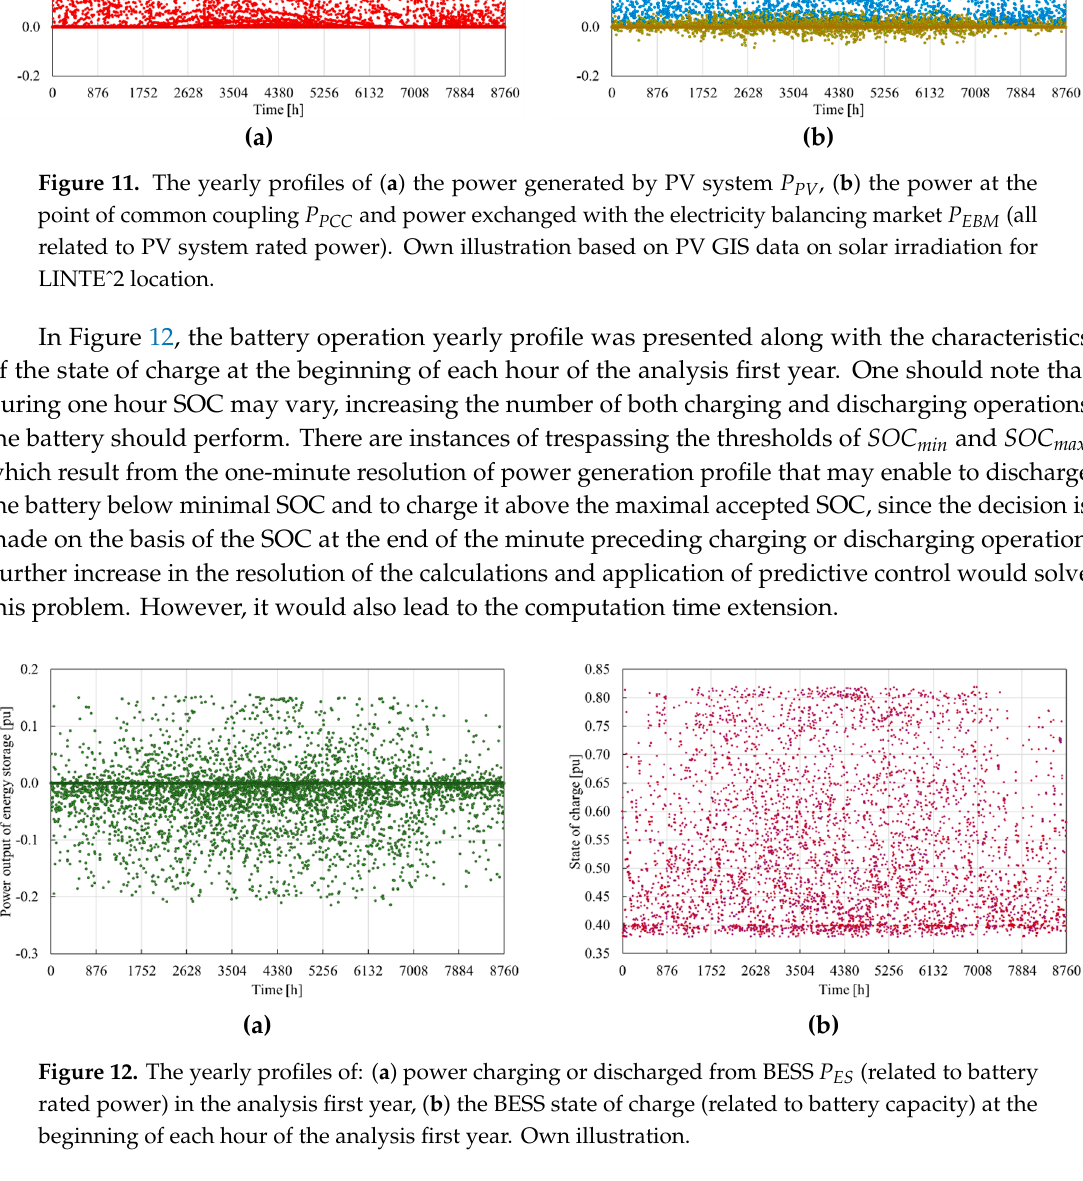
Figure 12. The yearly profiles of: ( a ) power charging or discharged from BESS P ES (related to battery rated power) in the analysis first year, ( b ) the BESS state of charge (related to battery capacity) at the beginning of each hour of the analysis first year. Own illustration.